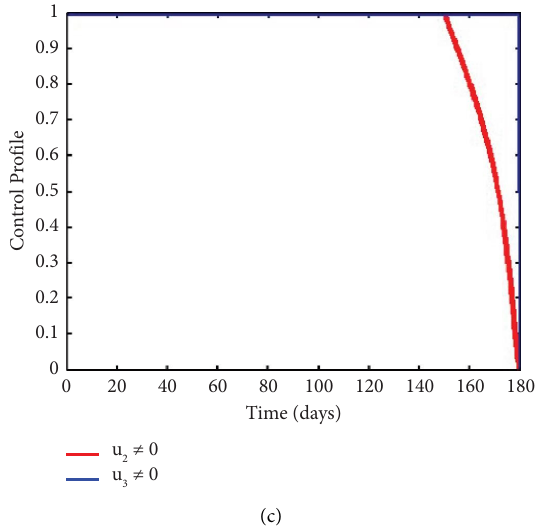
Figure 5: Simulation result with strategy of vaccination u